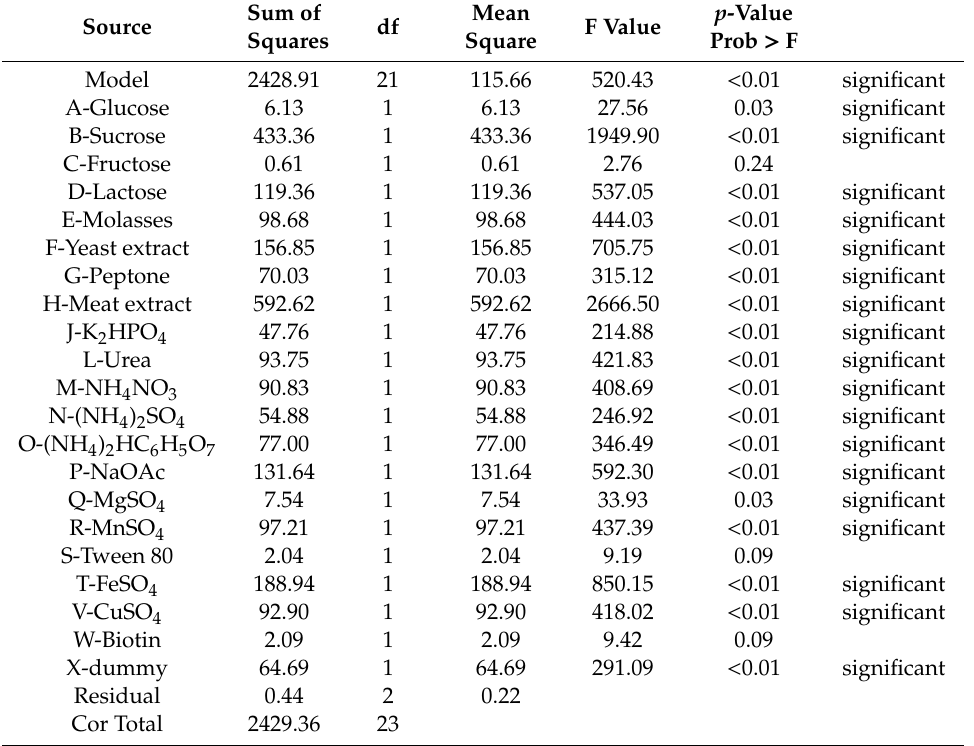
Table 2. ANOVA of PBD for the e ff ects of medium components on tryptophan production by P. acidilactici